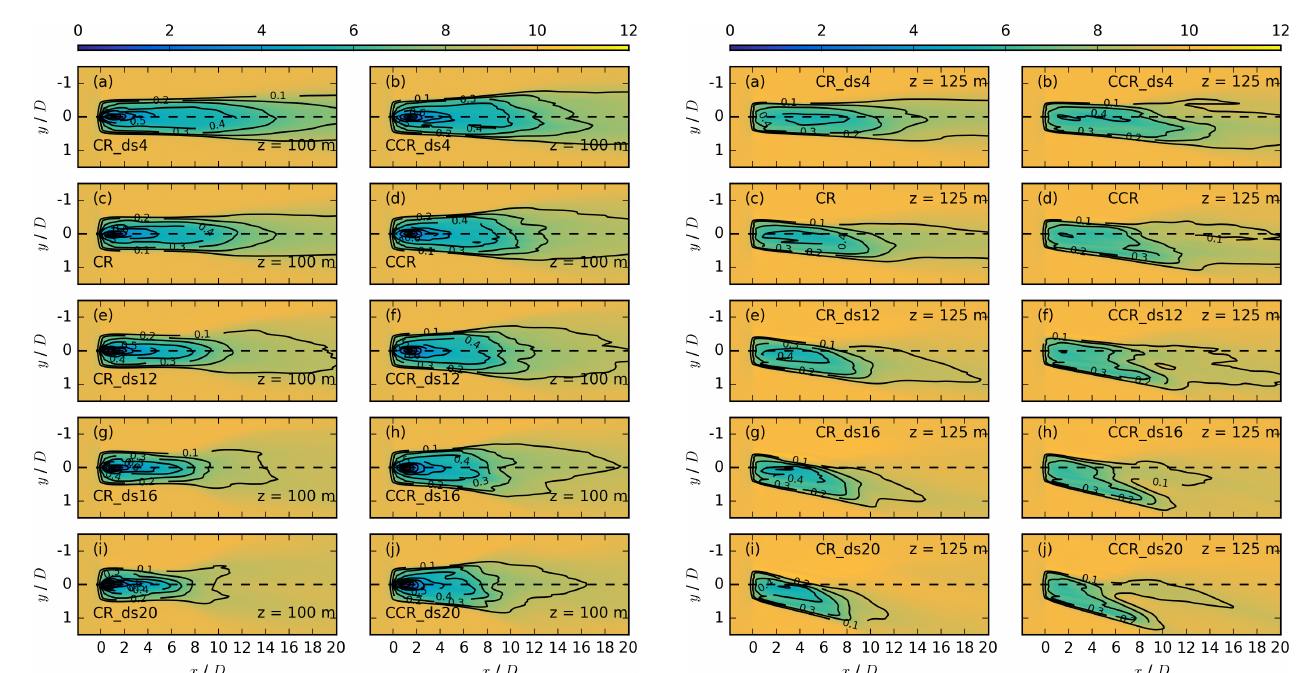
Figure 10. Contours of the streamwise velocity u i,j,k per second for different directional shears at z = 100m for CR_ds4 in (a) , CCR_ds4 in (b) , CR in (c) , CCR in (d) , CR_ds12 in (e) , CCR_ds12 in (f) , CR_ds16 in (g) , CCR_ds16 in (h) , CR_ds20 in (i) , and CCR_ds20 in (j) , each averaged over 30min. The black con- tours represent the velocity deficit VD i,j,k cation.